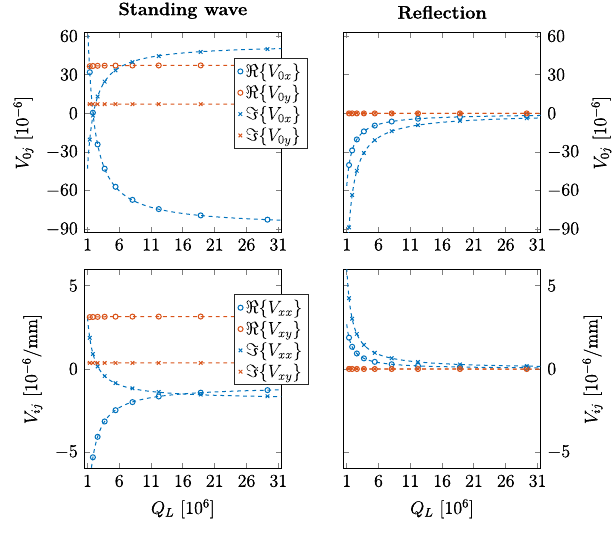
FIG. 8. Normalized complex kick coefficients ½ V 0 x ; V 0 y ; V xx ; V xy (cid:3) for the downstream coupler region as calcu- lated via Eq. (16) with different field maps, reflecting different loaded quality factors Q L . Plotted are the values related to the standing wave (left) and the reflection dependent part (right). The values are listed in Tables II and